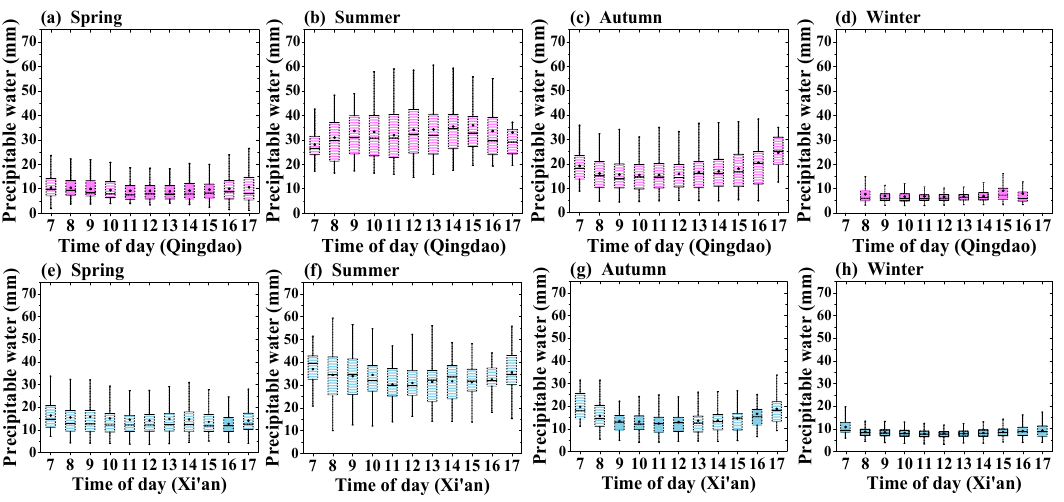
Figure 9. Hourly box plots of PW: ( a ) spring (Qingdao), ( b ) summer (Qingdao), ( c ) autumn (Qing- dao), ( d ) winter (Qingdao), ( e ) spring (Xi’an), ( f ) summer (Xi’an), ( g ) autumn (Xi’an), and ( h ) winter (Xi’an).